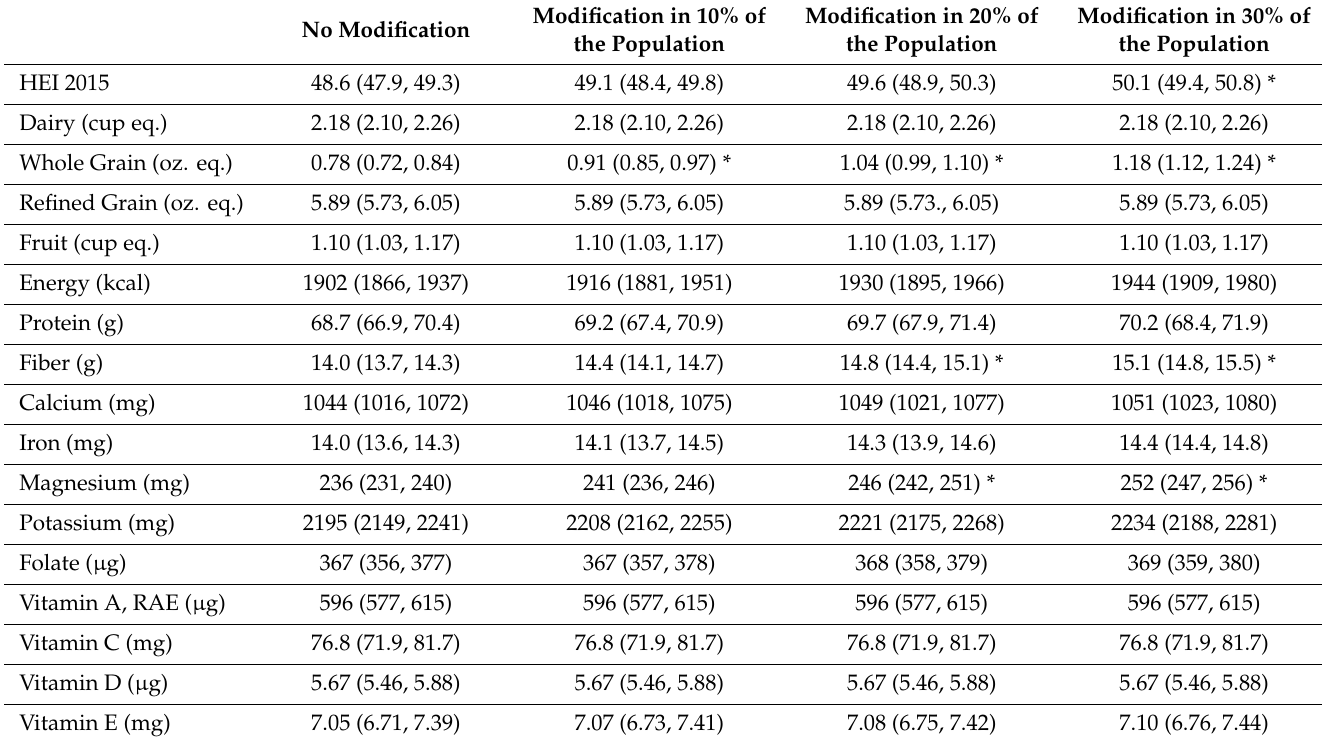
Table 5. E ff ect of adding one reference amount customarily consumed (RACC) of oatmeal on diet quality and on the intake of select food groups and nutrients